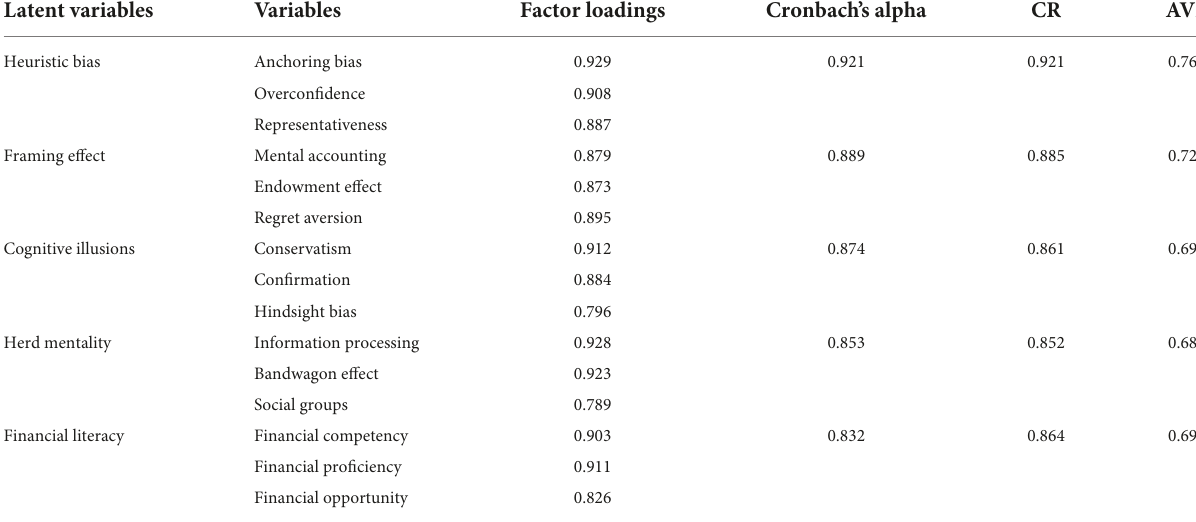
TABLE 2 Confirmatory factor analysis results of measurement model.